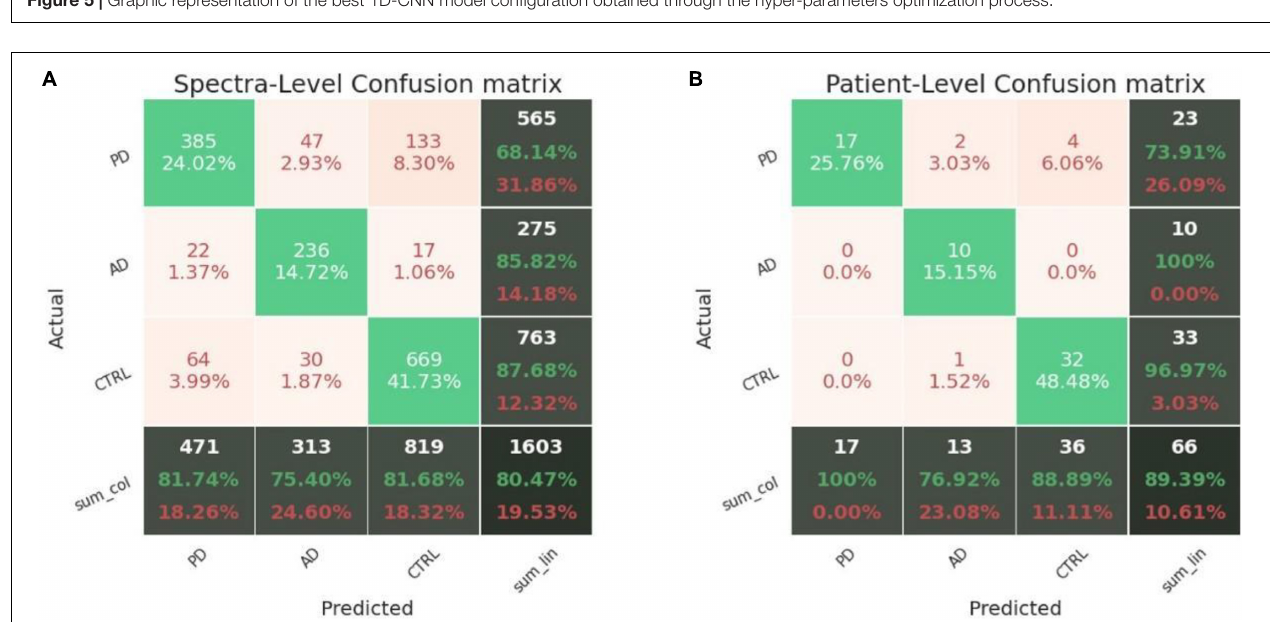
Figure 5 | Graphic representation of the best 1D-CNN model configuration obtained through the hyper-parameters optimization process.